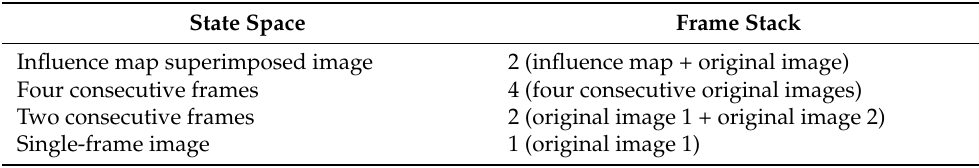
Table 5. “Frame stack” in four-group comparison experiments.